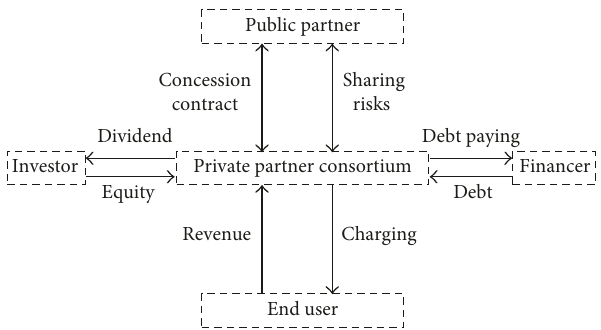
Figure 1: Schematic correlation of a Public-Private Partnership